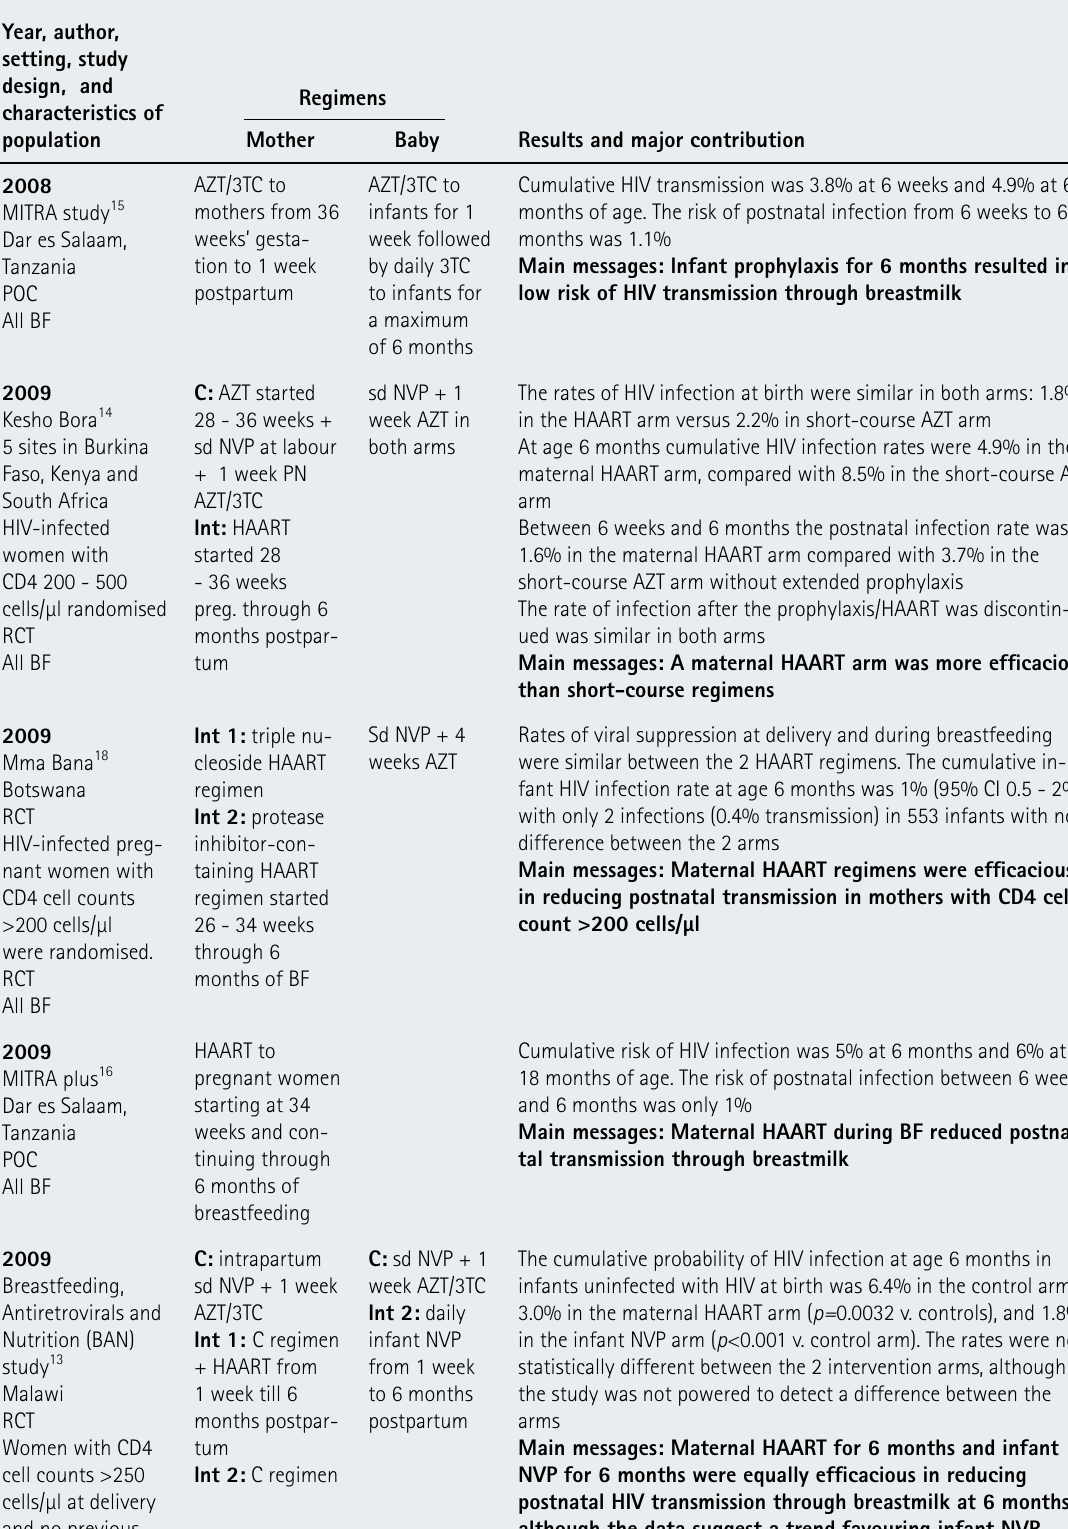
TABLE I. KEY STUDIES THAT HAVE CONTRIBUTED TO THE BODY OF KNOWLEDGE ON HIV AND INFANT FEEDING